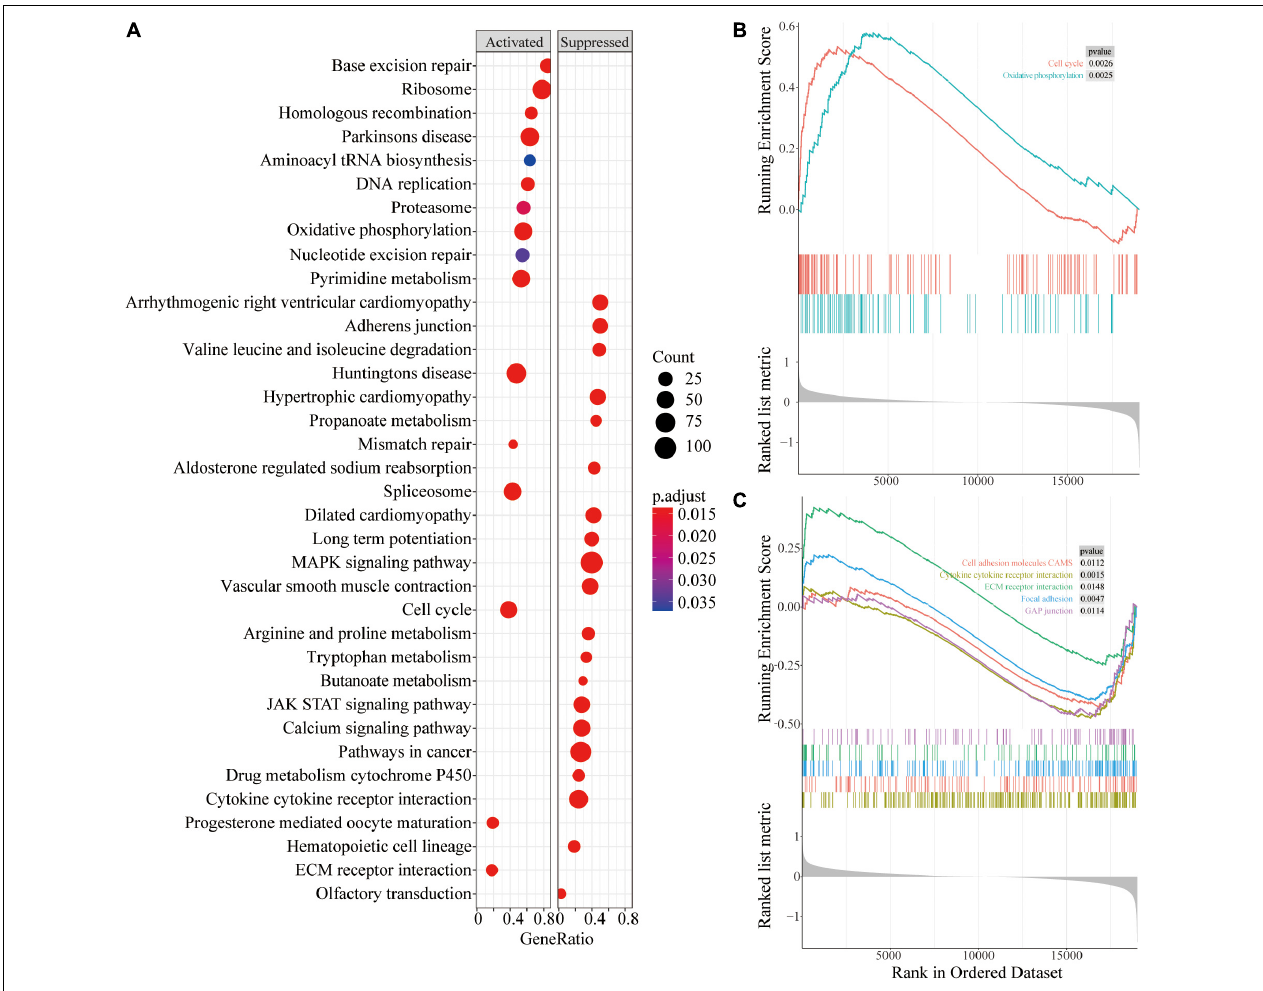
FIGURE 8 | Gene Set Enrichment Analysis of different risk groups. (A) Bubble chart of GSEA analysis in different risk groups; (B) GSEA analysis of oxidative phosphorylation and cell cycle in different risk groups; (C) GSEA analysis of pathways related to cell connections in different risk